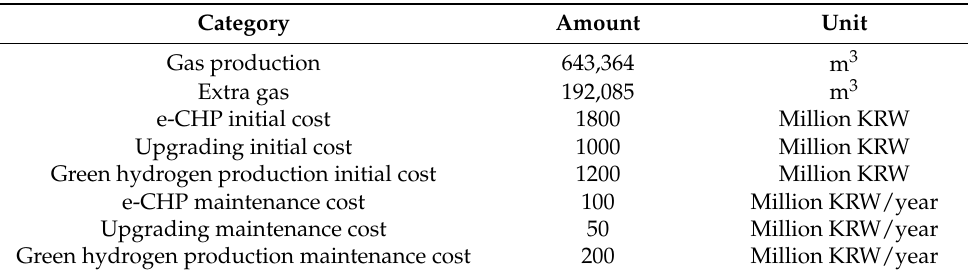
Table 6. Facility B fixed